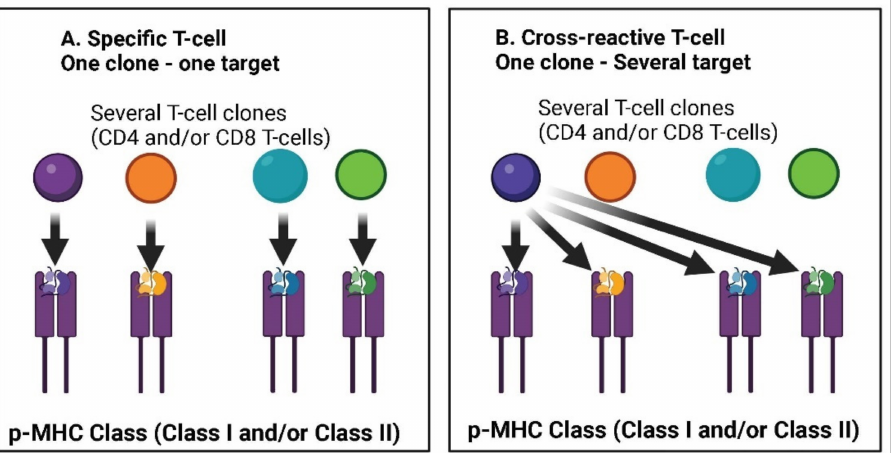
Figure 2. T-cell cross reactivity (Heterologous adaptive T cell-mediated immunity). ( A ). Each colored sphere represents a specific T cell which is directed to a corresponding antigen presented on the